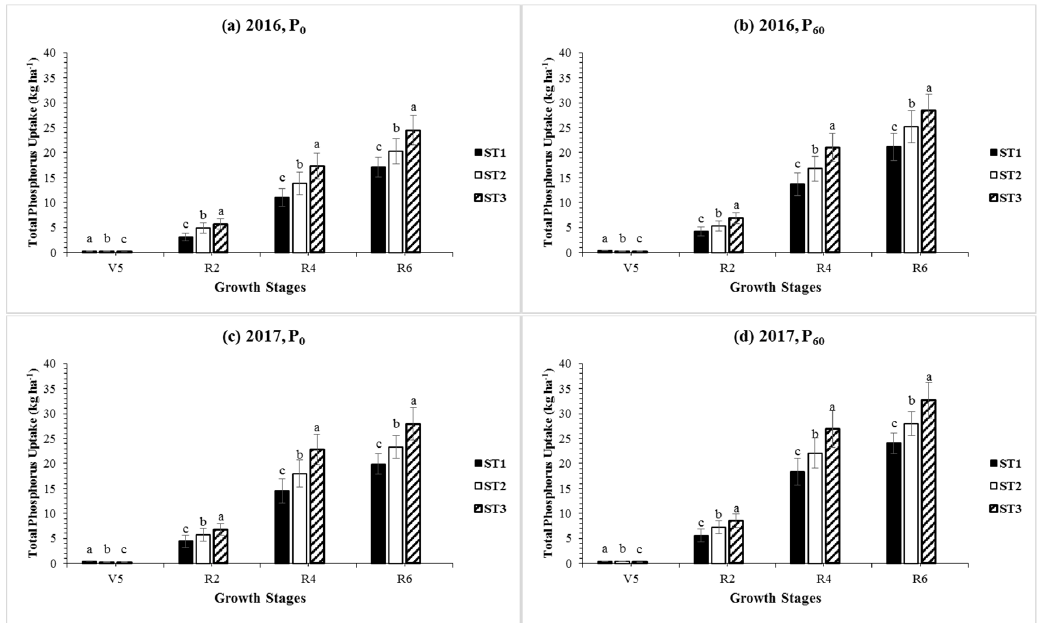
Figure 4. Total phosphorus uptake of relay intercrop soybean in maize as affected by three different sowing times at two rates of phosphorus fertilizer (P 0 ; A and C , and P 60 ; B and D ) during the cropping seasons of 2016 and 2017. ST 1 , ST 2 , and ST 3 represents the sowing times 15–20 May (90 days of co-growth period in maize soybean relay intercropping system (MSICS)), 5–10 June (70 days of co-growth period in maize soybean relay intercropping system (MSICS)), and 25–30 June, (50 days of co-growth period in maize soybean relay intercropping system (MSICS)), respectively. V 5 , R 2 , R 4 , and R 6 refer to five trifoliate, full flowering, full pod, and full seed phenological stages of soybean. The P 0 and P 60 refer to 0 and 60 kg phosphorus ha − 1 , respectively. Means are averaged over three replicates. Bars indicate ± standard errors, ( n = 3). Between bars in groups, different lowercase letters indicate a significant difference ( p < 0.05) between